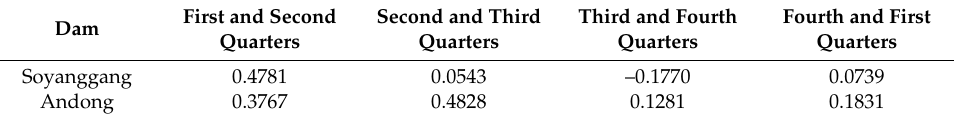
Table 4. The correlation coefficient of each quarter’s inflow to that of prior quarter.